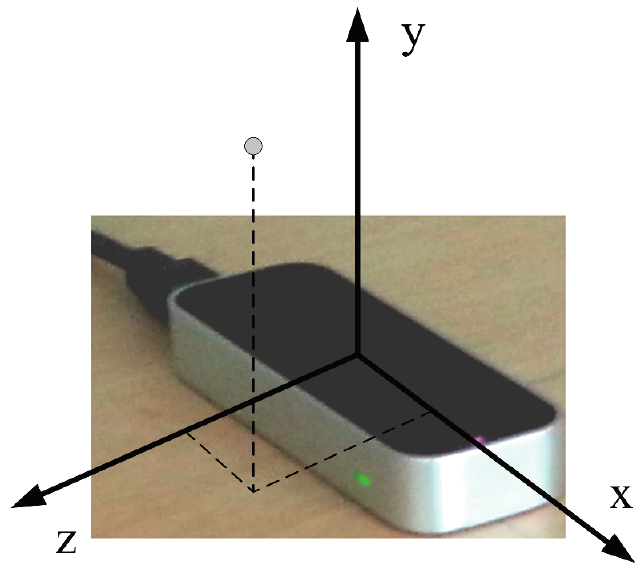
Figure 3. Leap Motion Controller and the coordinate system used to describe positions in its sensory